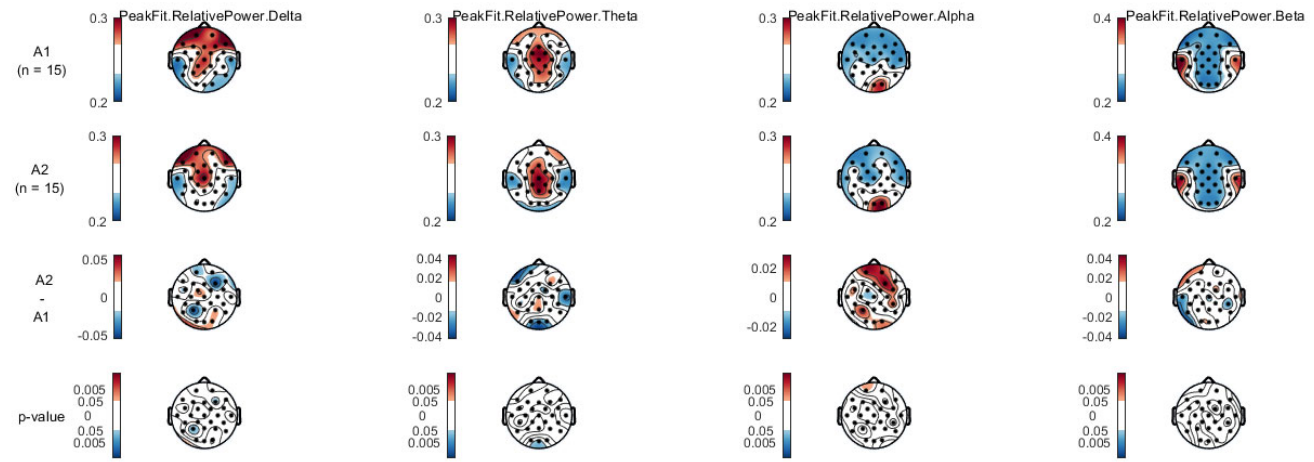
Figure 1. Bland–Altman plots for the EEG bands for the three exercise conditions. The Y ‐ axis corre ‐ sponds to the difference between inter ‐ day measurements, the dashed gray lines correspond to the 95% LOA, and the black line corresponds to the bias. The blue line corresponds to the regression line between bias and the differences of repeated measures.